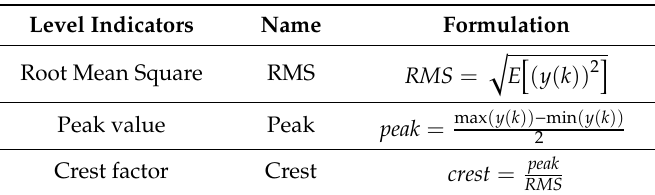
Table 2. The most widely used level indicators for a discrete